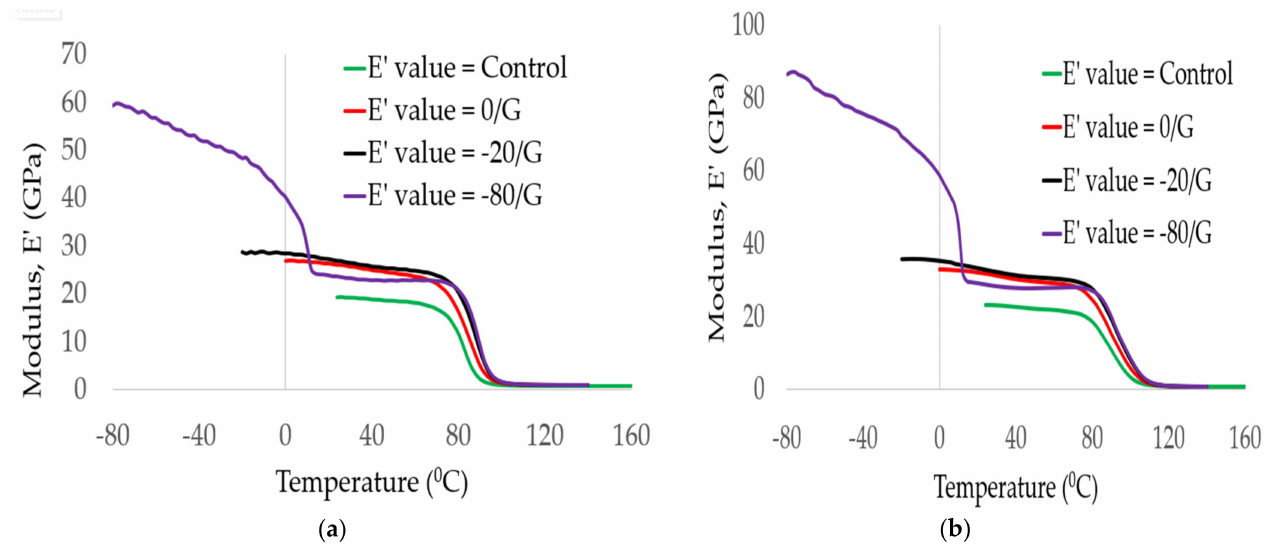
Figure 6. Storage modulus comparisons between GFRP laminates at the frequency ( a ), 1 Hz, ( b ), 100